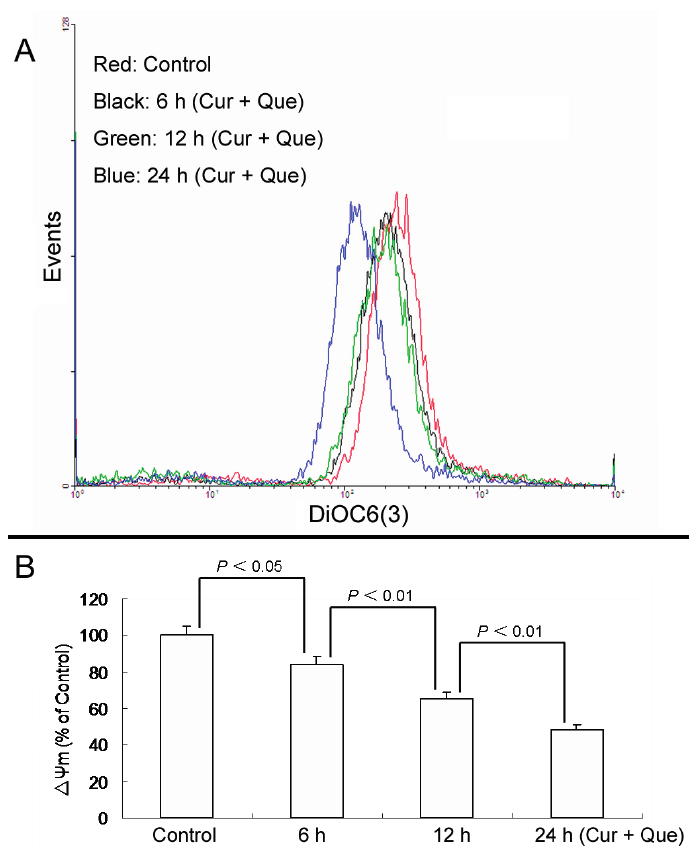
Figure 4. Combination of quercetin and curcumin decreased ΔΨ m in a time-dependent manner. After treatment with combination of quercetin and curcumin for 6, 12 and 24 h, cells were incubated with DiOC6(3) and then measured by flow cytometry. ( A ) Collapse of ΔΨ m was observed in MGC-803 cells. ( B ) ΔΨ m levels are expressed as percentage of MFI compared to control group. Data are expressed as mean ± SD of at least three determinations. p < 0.05 and p < 0.01 represent a significant difference among